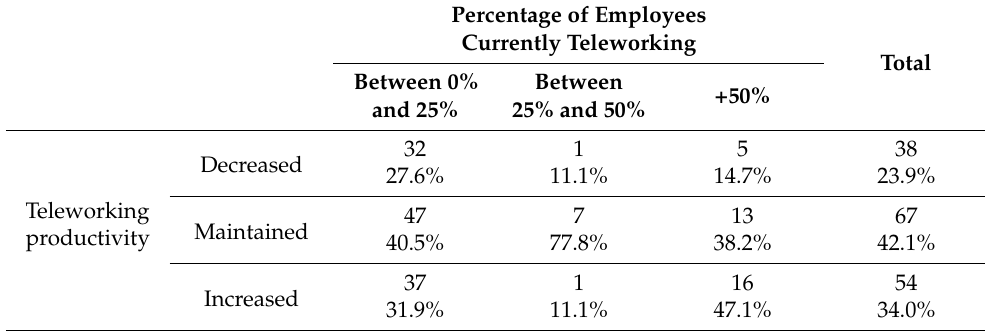
Table 1. Results of the chi-square test of productivity*education. Table 2. Results of the chi-square test of the percentage of teleworking